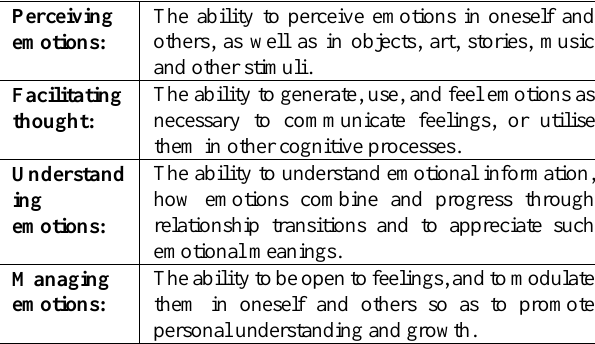
Table 2: Overview of the four-branch model of emotional intelligence